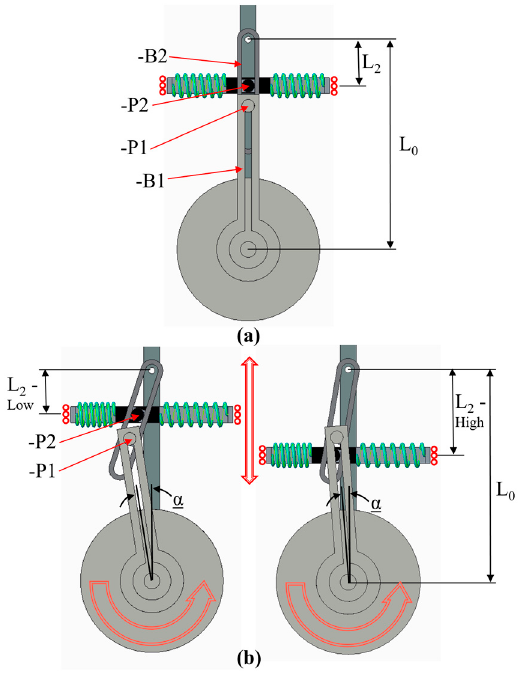
Figure 3. The ARES-XL working principle: ( a ) ARES-XL in rest position; and ( b ) ARES-XL deflected at different stiffness.